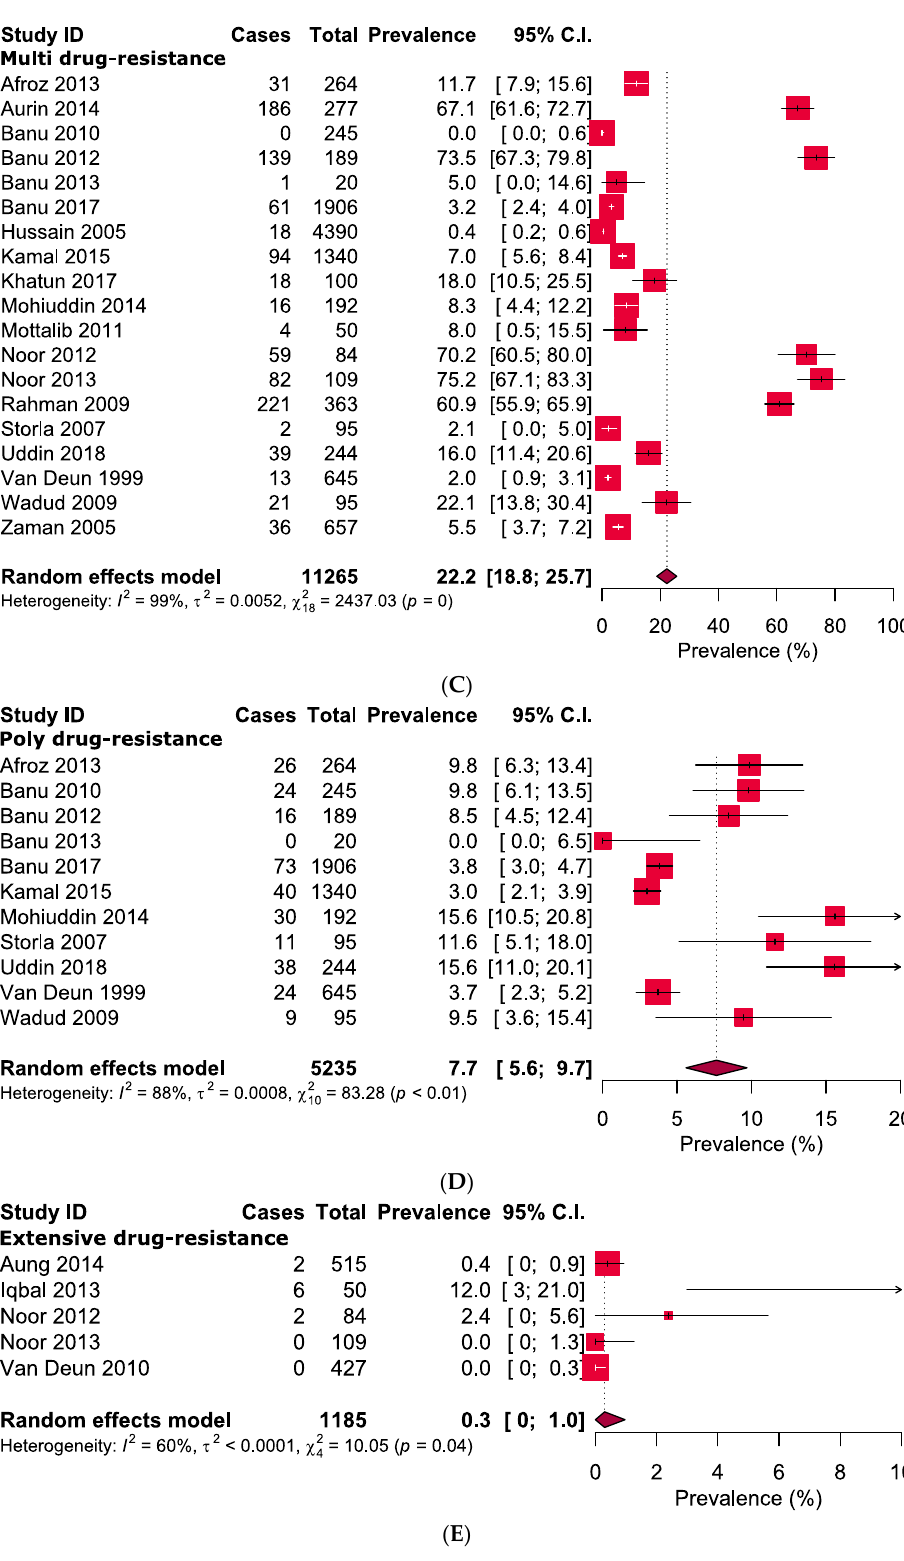
Figure 3. Prevalence of ( A ) any-DR, ( B ) mono-DR, ( C ) multi-DR, ( D ) poly-DR, and ( E ) extensive-DR in pulmonary tuberculosis in Bangladesh.